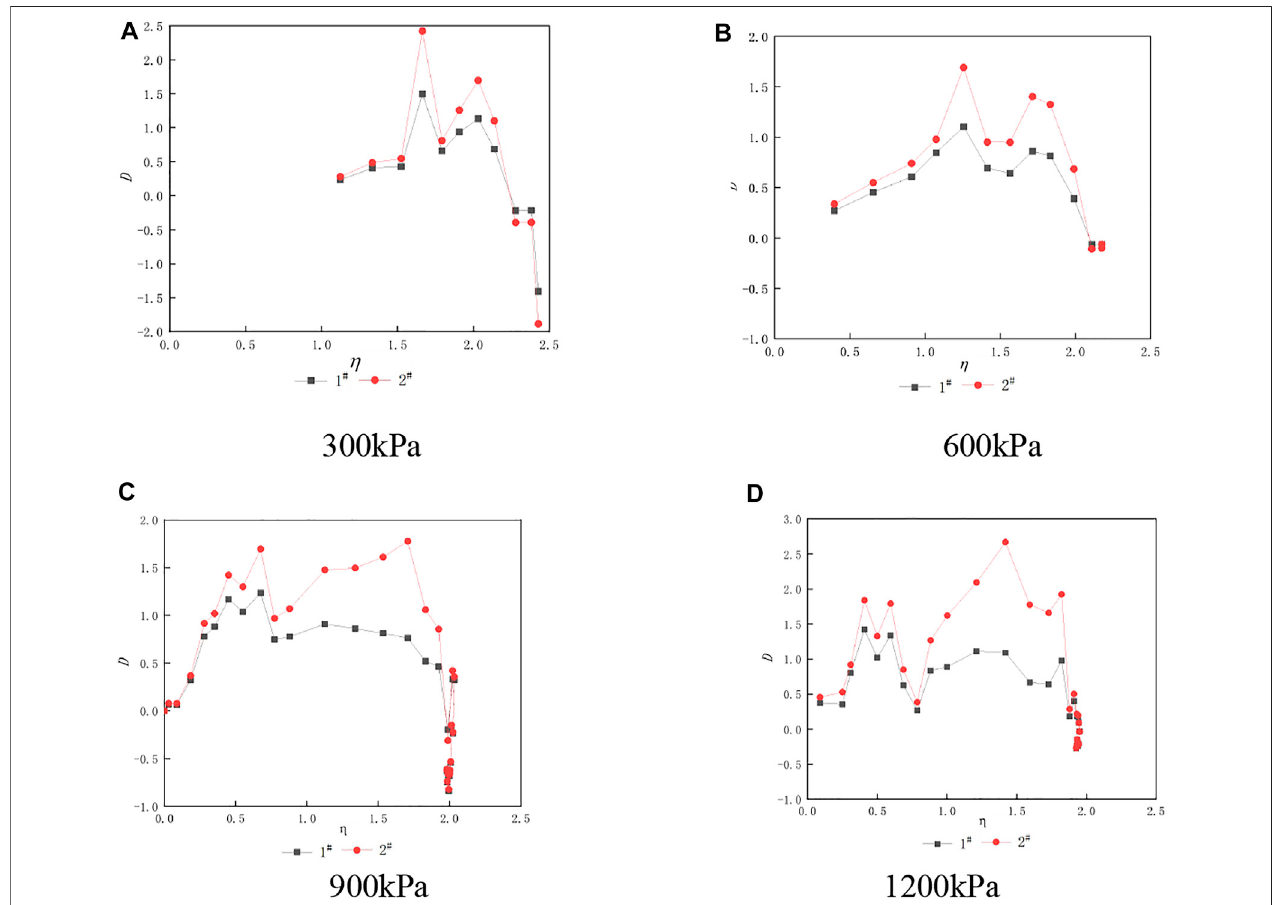
FIGURE12| ThedilatancyratioofLCSGmaterialwithcementedcontentof60kg/m3underdifferentcon fi ningpressures. (A) 300 kPa (B) 600 kPa (C) 900 kPa (D) 1,200 kPa.